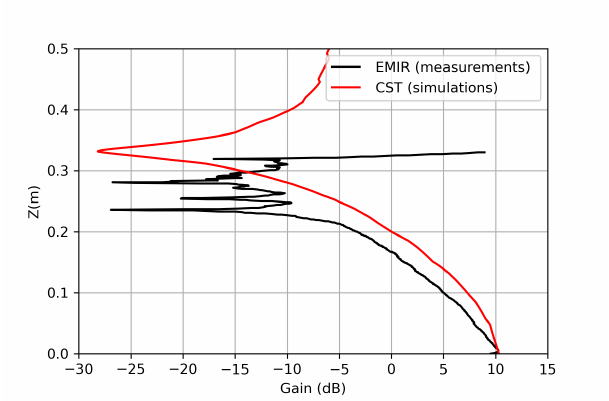
FIGURE 9. Simulated and measured gain at 1.1 GHz along a line lying in the vertical plane (Kapton film at X=59 cm from the monopole)